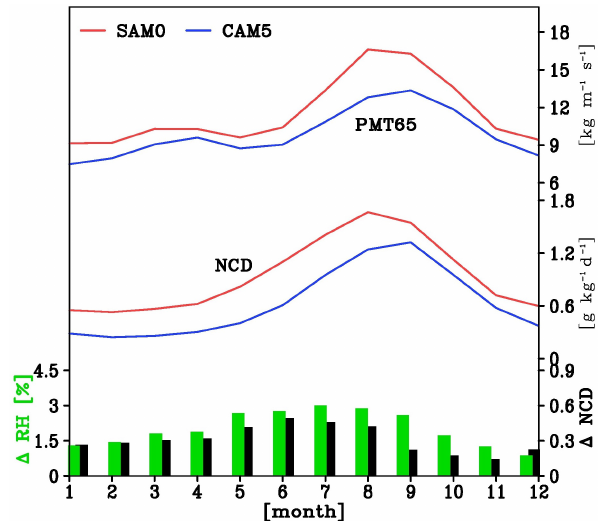
Figure 6. Annual cycles of vertically integrated zonal-mean pole- ward moisture transport in gkg − 1 ms − 1 at 65 ◦ N (PMT65) and net condensation rate of water vapor into cloud liquid (NCD) in gkg − 1 d − 1 averaged over the Arctic from SAM0 (red line) and CAM5 (blue